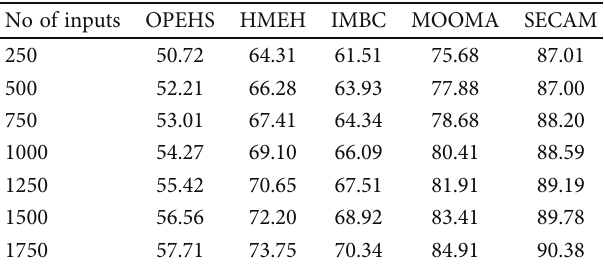
Table 5: Comparison of production monitoring.